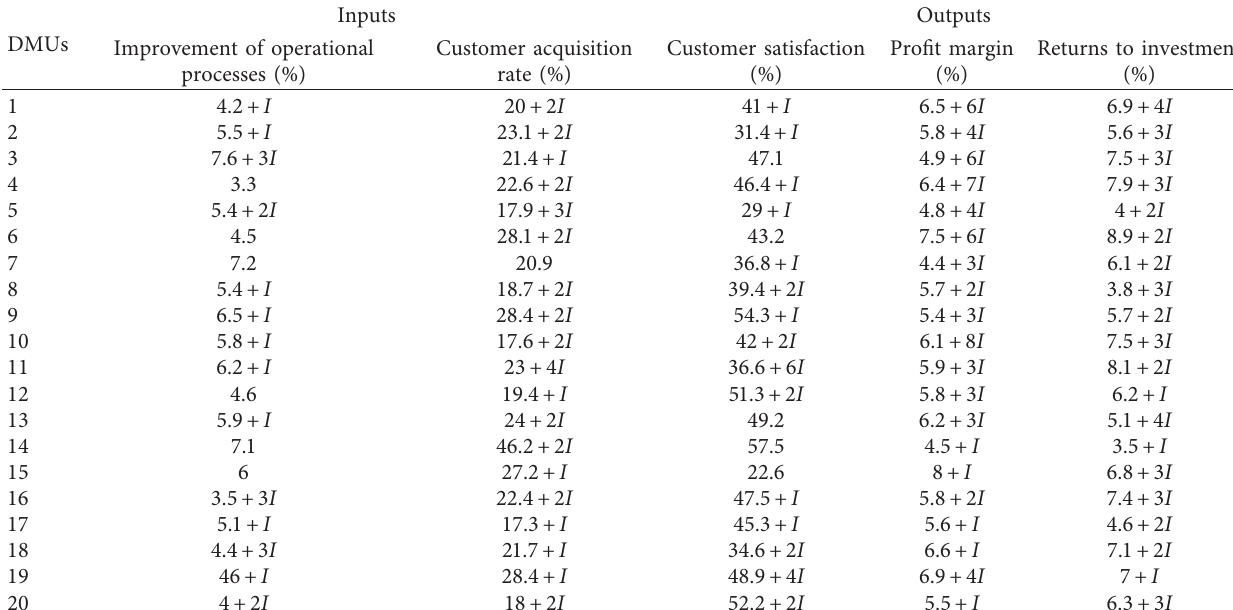
Table 2: Input and output of results